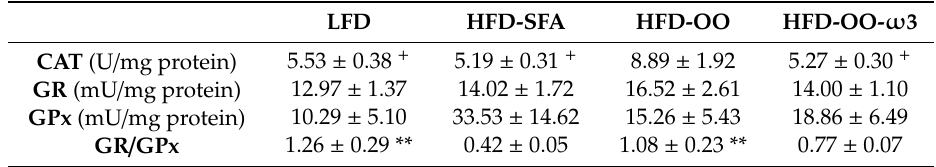
Table 4. Antioxidant enzyme activity in plasma from mice fed with LFD, HFD-SFA, HFD-OO,